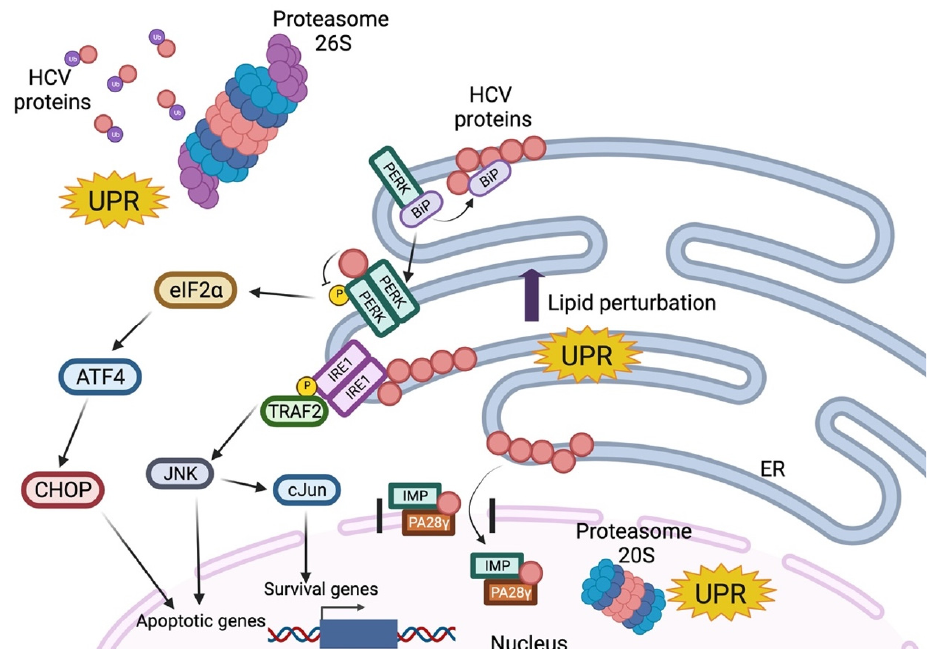
Figure 3. Unfolded Protein Response induced by HCV proteins. Normally BiP is attached to PERK in an inactive state. Unfolded and/or HCV proteins sequester BiP from PERK, allowing its oligomerization and auto-phosphorylation. Activated PERK (which phosphorylates eIF2 α to inhibit global protein synthesis) is inhibited by viral proteins in the cytosol. This prevents the translation of ATF4, which activates CHOP, a pro-apoptotic transcription factor. On the other hand, the viral proteins can activate IRE1 and recruit TRAF2 to initiate a cascade of phosphorylation of JNK (pro-apoptotic) and c-Jun (pro-survival). Meanwhile, mature HCV proteins release to the cytoplasm where they can be polyubiquitinated (Ub) and degraded by proteasome 26S. Simultaneously, some viral proteins can be imported into the nucleus by their association with PA28 and IMP, which are degraded by proteasome 20S independent of ubiquitin. All these molecular pathways are involved in the unfolded protein response, which finally regulates some survival, inflammation, and apoptotic genes.